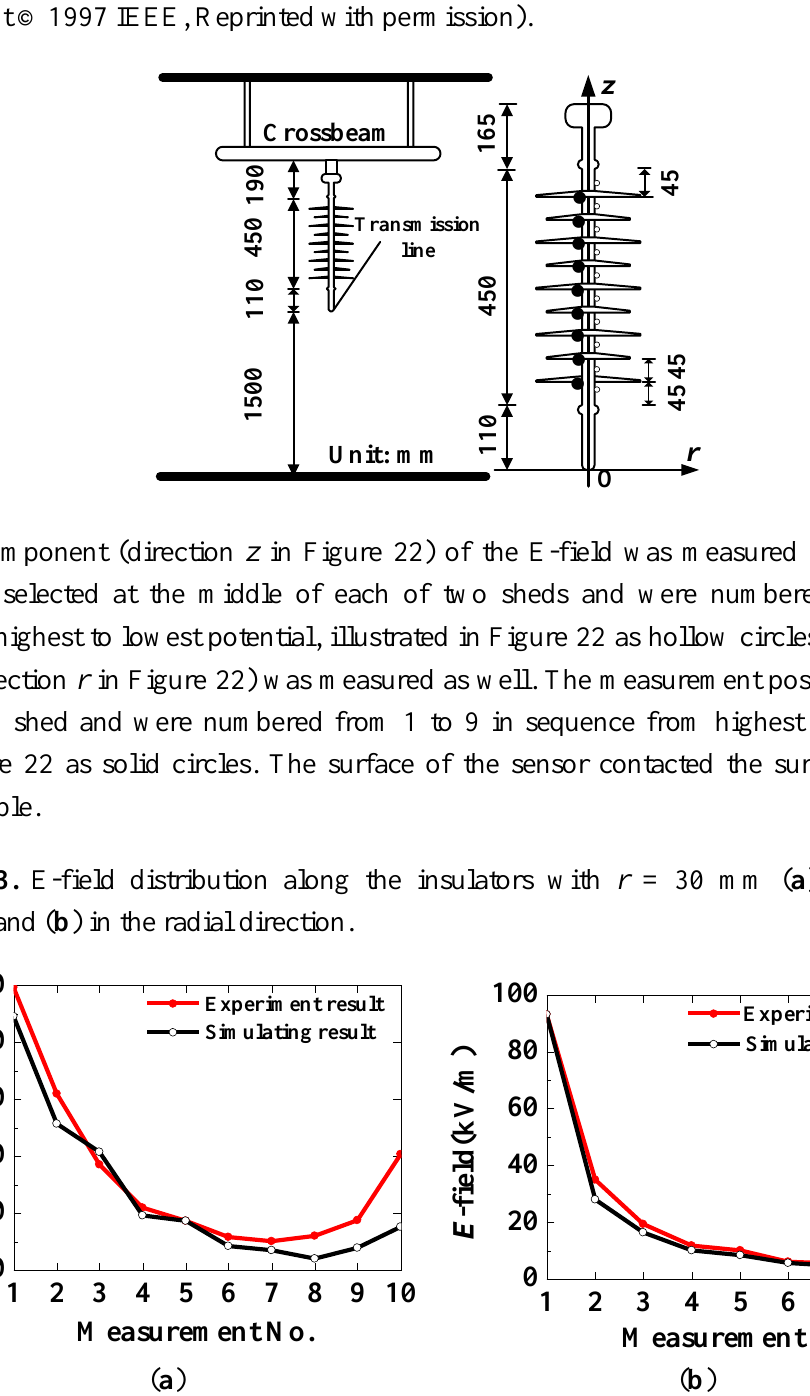
Figure 22. Measurement of E-field distribution along a composite insulator [84] (Copyright © 1997 IEEE, Reprinted with permission).